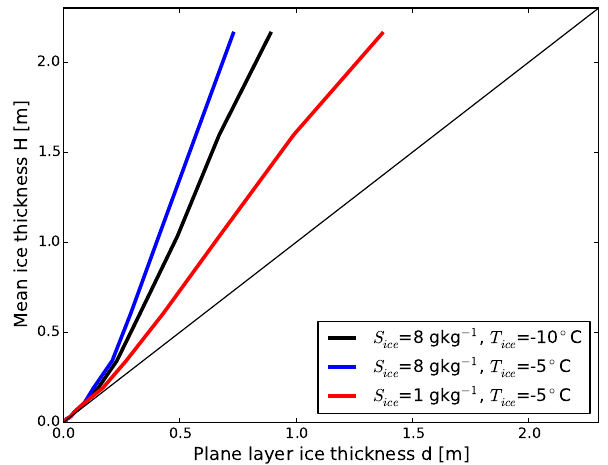
Figure 10. Relationship between the plane ice layer thickness d ice and the mean inhomogeneous ice layer thickness H at different T ice and S ice . The thin black line is the 1.1 unity line.